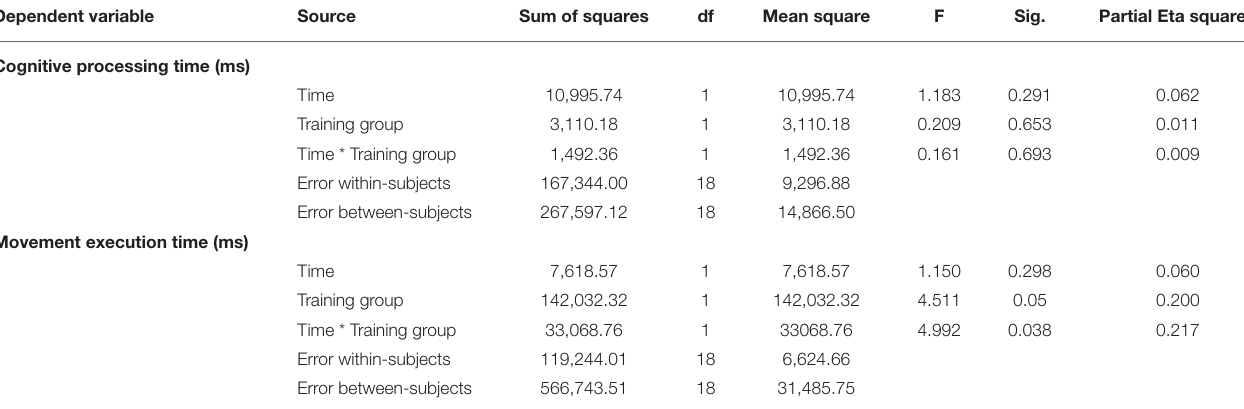
TABLE 2 | Two (training group) × two (time), mixed model analysis of variance on cognitive processing time and movement execution time. Dependent variable Source Sum of